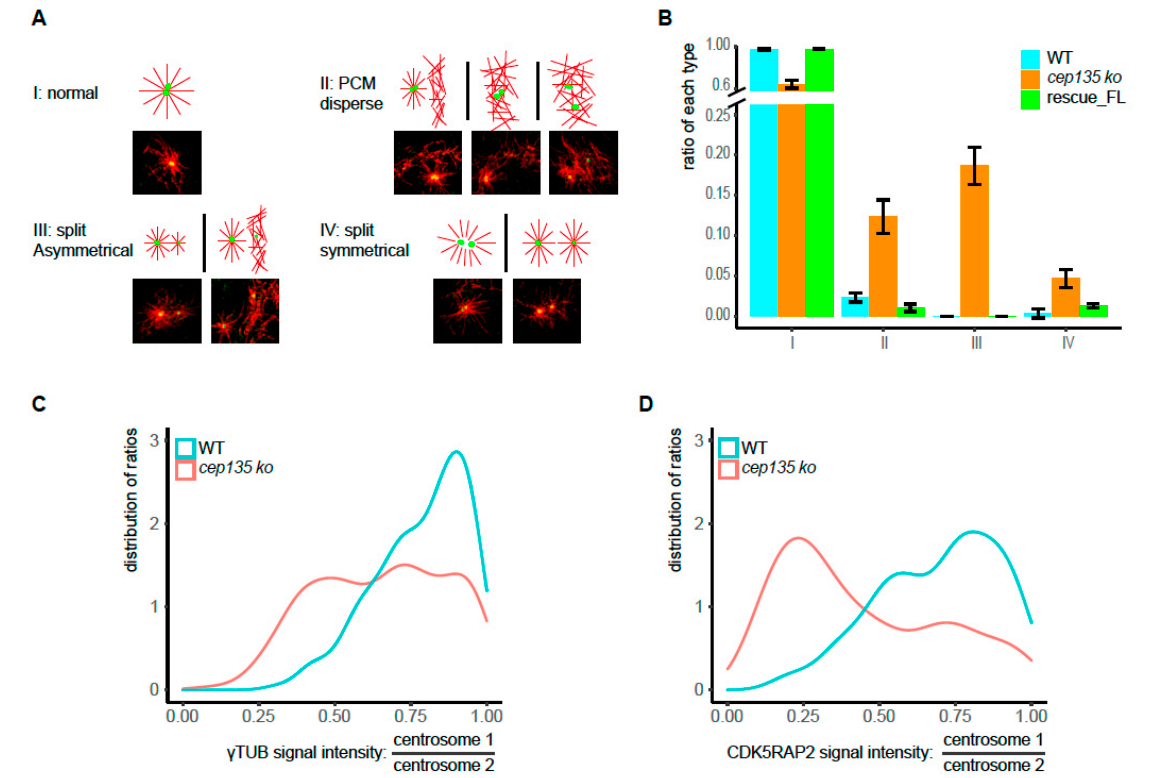
Figure 7. Imbalanced MTOC functions in cep135 KO cells in interphase. ( A ) The typical patterns of